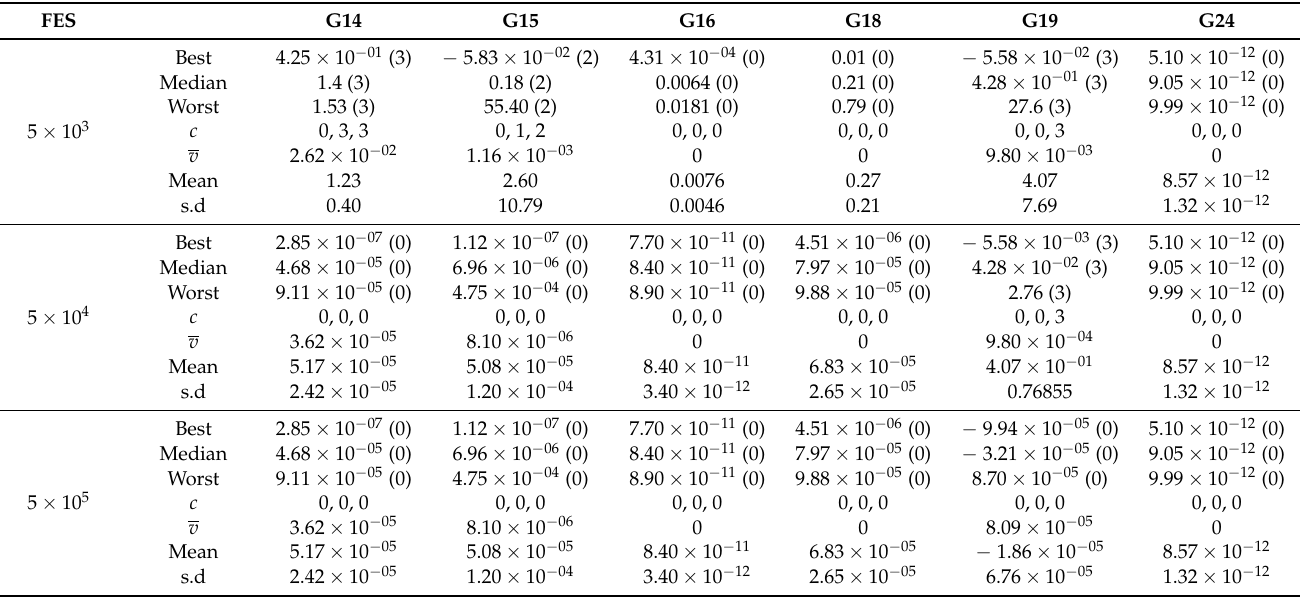
Table 4. Error values achieved when FES = 5 × 10 3 , FES = 5 × 10 4 , FES = 5 × 10 5 for Problems G14, G15, G16, G18, G19 and G24.